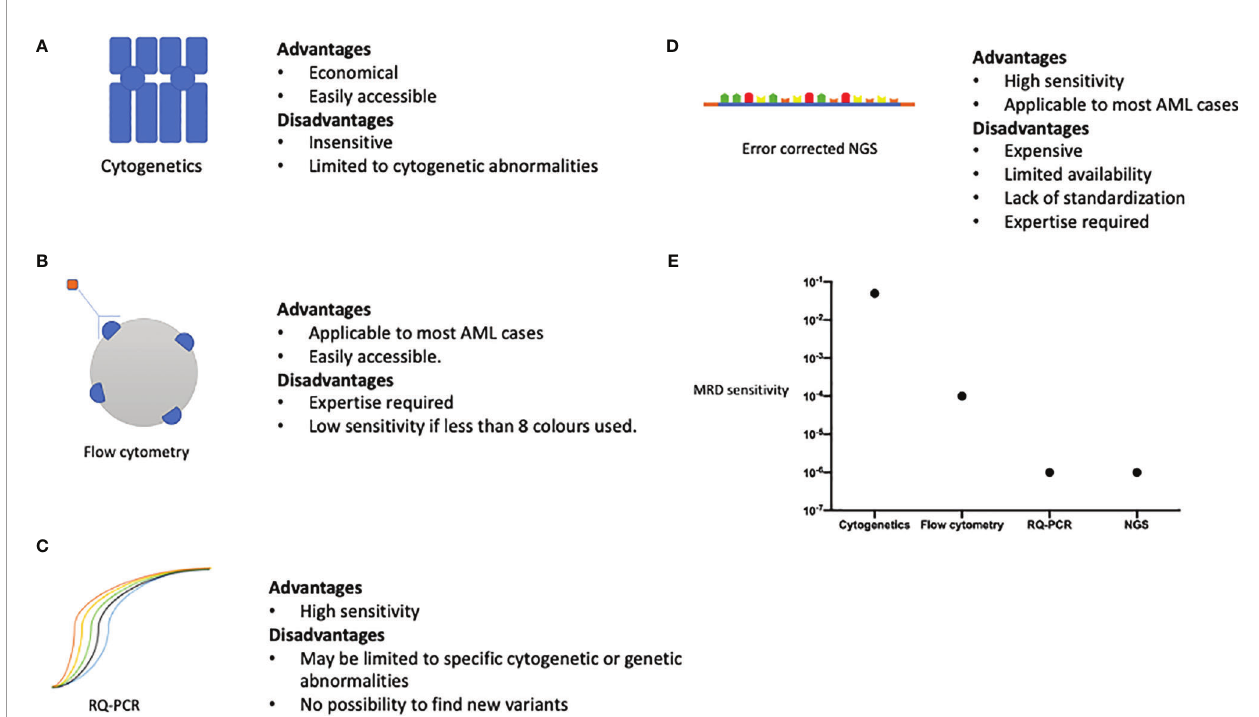
FIGURE 1 | A summary of the advantages and disadvantages of methods of MRD assessment, (A) cytogenetic analysis, (B) multi-parametric fl ow cytometry, (C) Quantitative polymerase chain reaction. (D) Next generation sequencing. (E) Represents the sensitivity of each method of MRD assessment method comparing the ability of each method to detect a single AML cell amongst normal haemopoietic cells. Sensitivities are as follows: Cytogenetics 1 in 20, Flow cytometry 1 in 10,000, RQ-PCR 1 in 1,000,000, NGS 1 in 1,000,000. Data adapted from Ravandi et al.